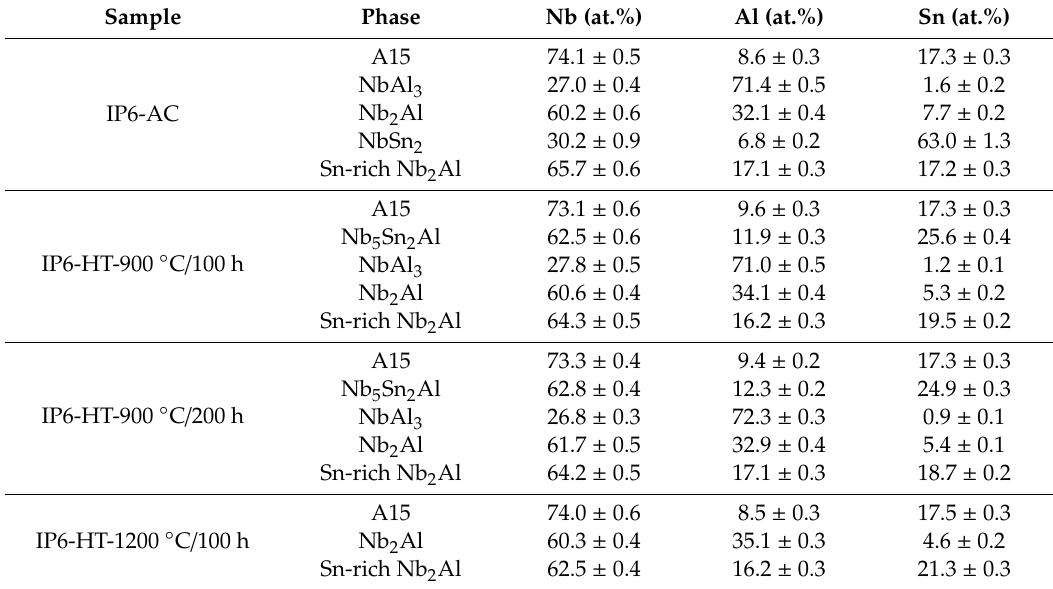
Table 4. EDS analysis of the phases in IP6-AC, IP6-HT 900 ◦ C / 100 h, IP6-HT 900 ◦ C / 200 h and IP6-HT 1200 ◦ C / 100 h